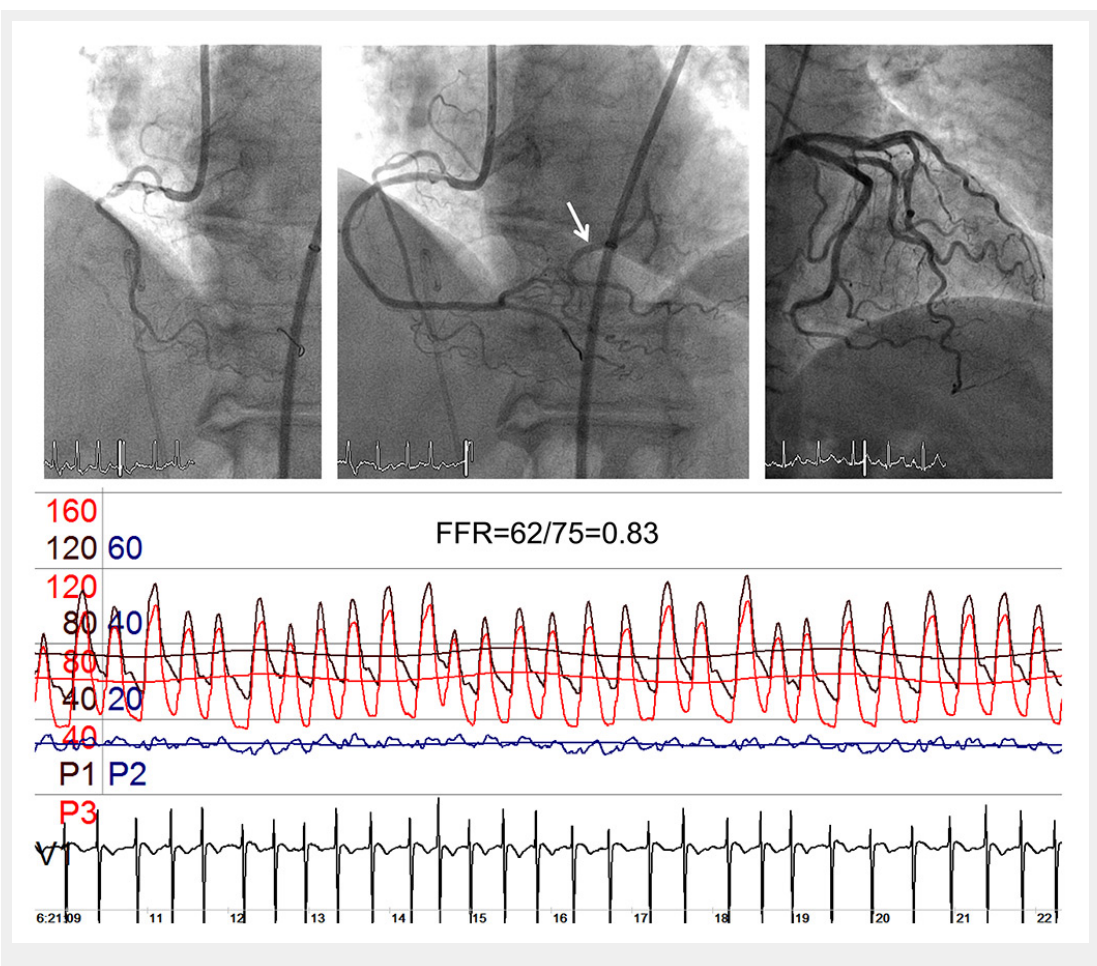
Figure 4 Coronary angiograms of the balloon-occluded right coronary artery (RCA, left upper panel), of the patent RCA with an ostial stenosis (mid upper panel) and showing part of the distal left circumflex coronary artery (arrow); the upper right panel depicts a left coronary angiogram with an identical trace of the distal left circumflex artery as shown in the mid upper panel. The pressure and ECG tracings are recorded during ostial RCA balloon occlusion: mean (P ao ) and phasic aortic pressure in black, mean (P occl ) and phasic coronary occlusive pressure in red, central venous pressure (CVP) in blue, intracoronary ECG. FFR = fractional flow reserve as P occl /P ao